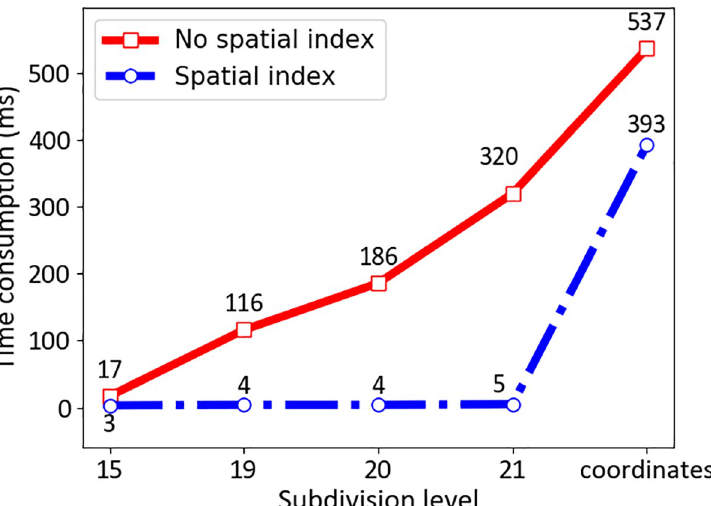
Fig 6. Time consumption for air route trafficability computation. Time consumption represents the average time it takes for the UAV to search its neighborhood with or without a large database supporting index.